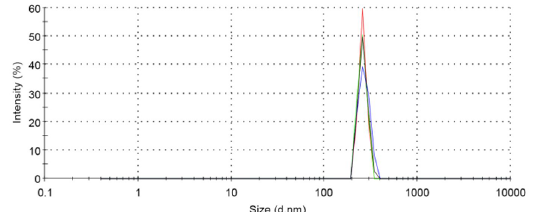
Figure 11. Batch 9 size distribution x intensity.